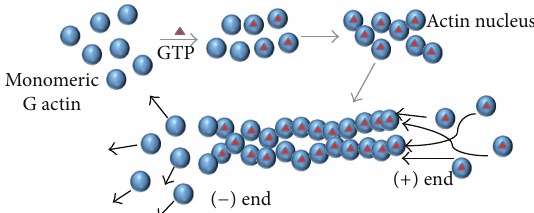
Figure 1: Formation of filamentous actin. Monomeric G actin can exchange GDP with GTP, depending on the energy status of the cell. Such GTP bound actin proteins are more stable and can form oligomers using weak noncovalent interactions. Such oligomers serve as nucleus for further oligomerization. Actin binding proteins (ABPs) can accelerate this process. Once oligomerized, the structure has polarity for adding new activated monomers. The (+) end can elongate the filamentous structure via adding new monomers, whereas on the ( − ) end the GTP bound actin is converted to GDP bound stage and dissociates from the filament. Such actin tread milling is a key component in regulation of cellular structure, morphogenesis, and